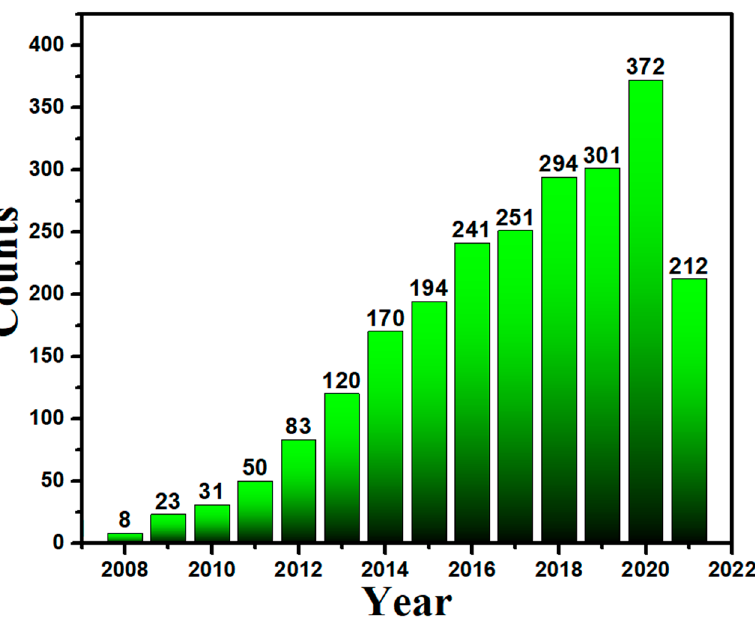
Figure 3. A histogram shows the frequency of paper publication on biological approaches for Ag NPs.